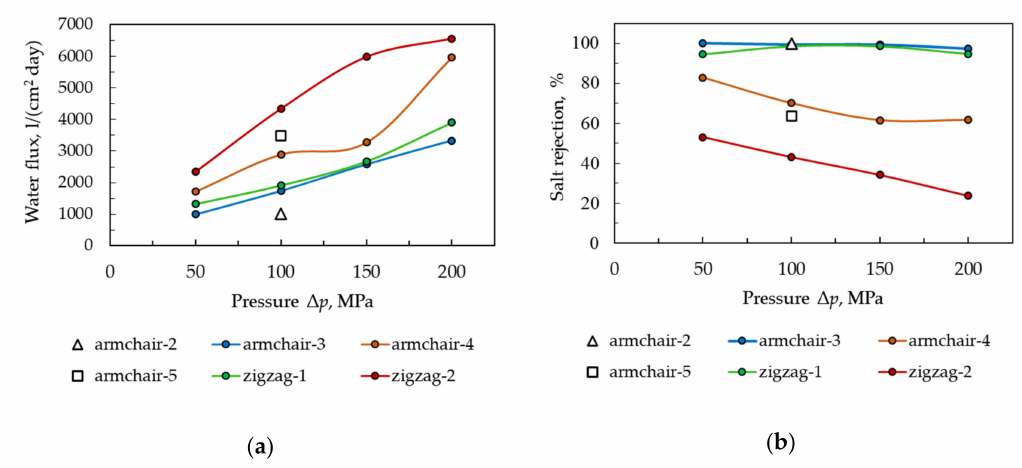
Figure 4. Water flux ( a ) and the percentage of salt rejection ( b ) of model membranes as a function of applied pressure